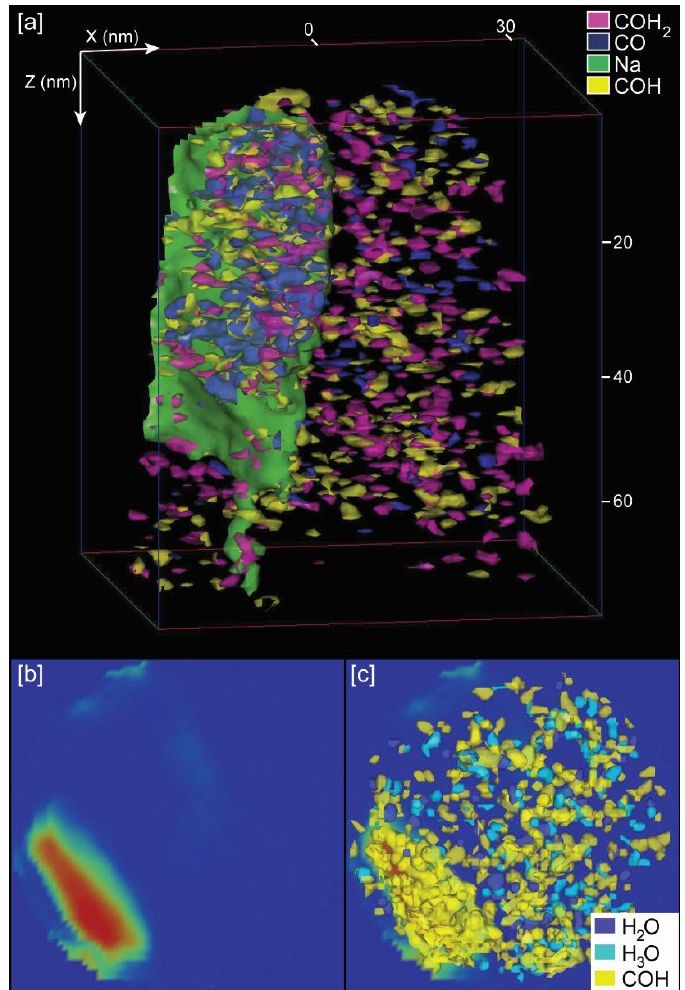
Figure 7. APT 3D tip reconstructions for calcite grown with chitin nanofibers: ( a ) Calcite tip with occluded chitin fragments and the presence of sodium; ( b ) Orthogonal projection view (along Z axis) of a slice of the tip showing the location of maxium ( red color ) Na concentration; ( c ) Same orthogonal projection in ( b ) with the superposition of those molecules (COH − , H 2 O, and H 3 O) corresponding to chitin. Notes: Dimensions, along Z and X axes, are in nm; chitin fragments recognized by CO − , COH − , COH 2 − , and associated water (H 2 O) and hydronium (H 3 O) molecules.